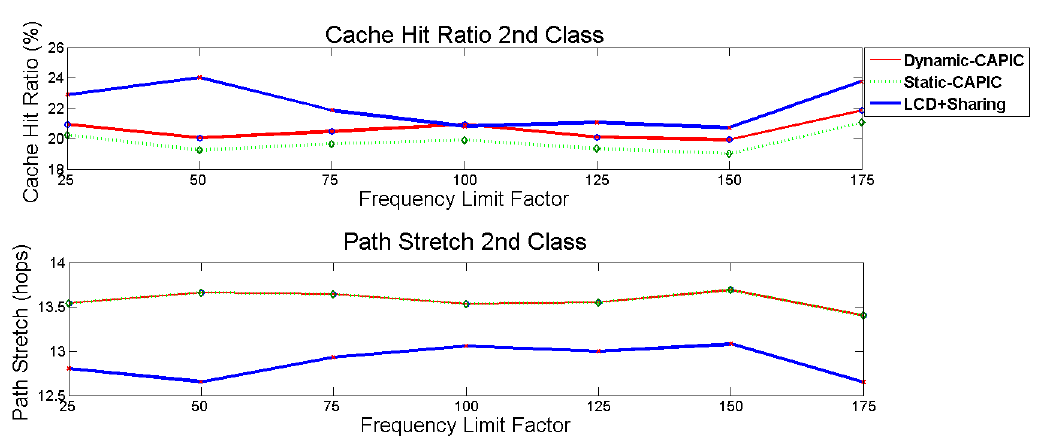
Figure 9. Cache hit ratio ( above ) and path stretch ( below ) 2nd class of Dynamic-CAPIC, Static-CAPIC, and LCD+sharing scheme.